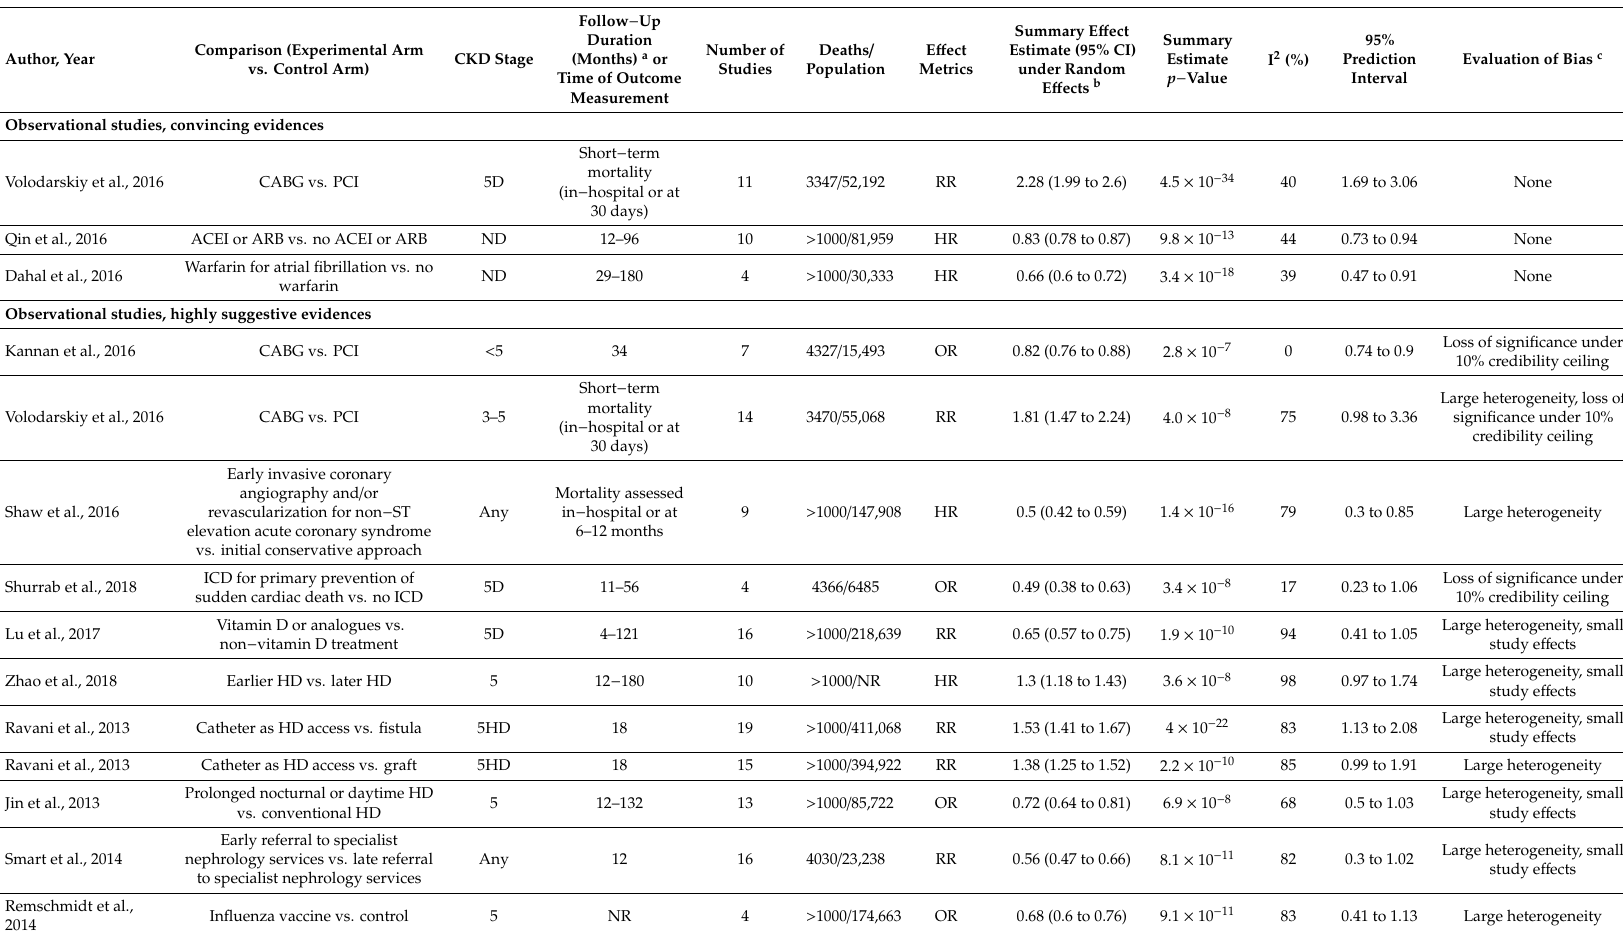
Table 2. Details of meta-analyses associating clinical intervention and all-cause mortality of patients with chronic kidney disease (presented were associations graded as convincing or highly suggestive for meta-analysis of observational studies, and associations having p -value < 0.05 for meta-analysis of randomized controlled